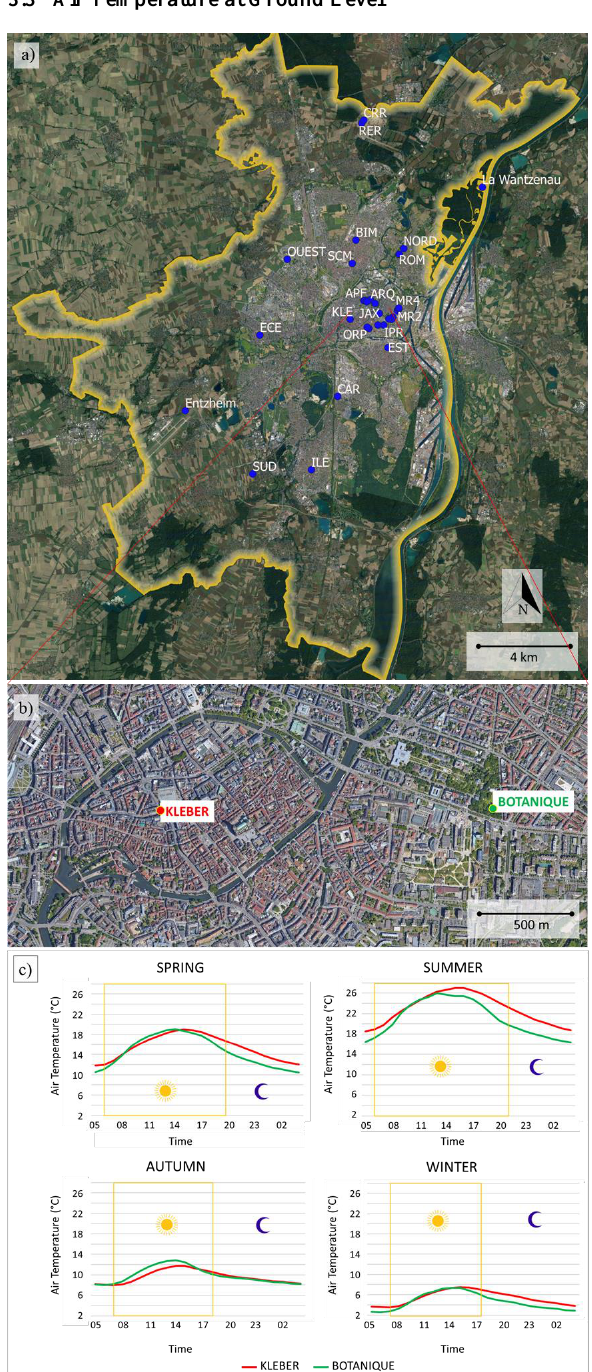
Figure 2. a) Location of the meteorological stations (blue points) in the Eurometropolitan area of Strasbourg (yellow boundary), b) Kleber and Botanique stations and c) the annual variations of air temperatures in such